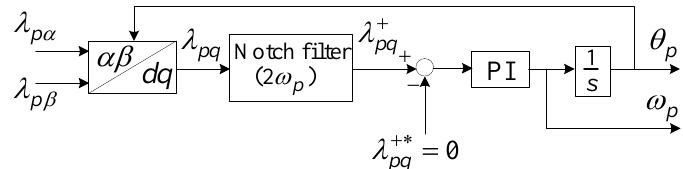
Figure 8. Block diagram of the phase-locked loop (PLL).